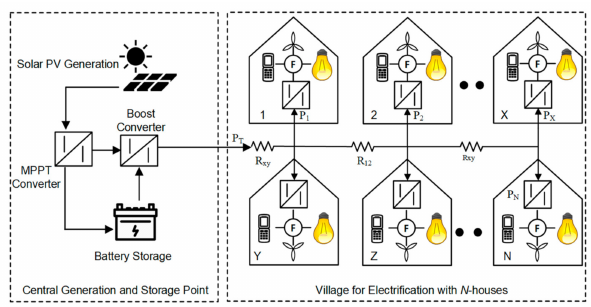
Figure 1. System diagram for centralized generation and centralized storage architecture